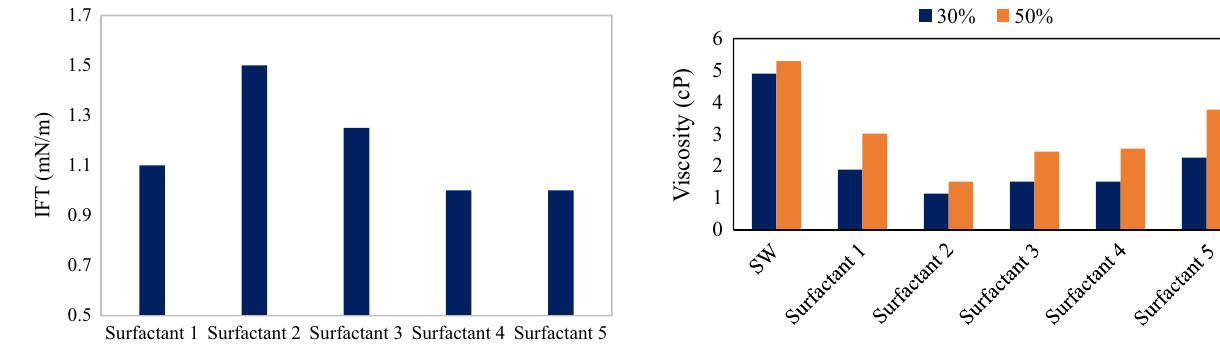
Fig. 3 Interfacial tension values for 0.2 wt.% surfactant solutions in brine with crude oil at 90 °C